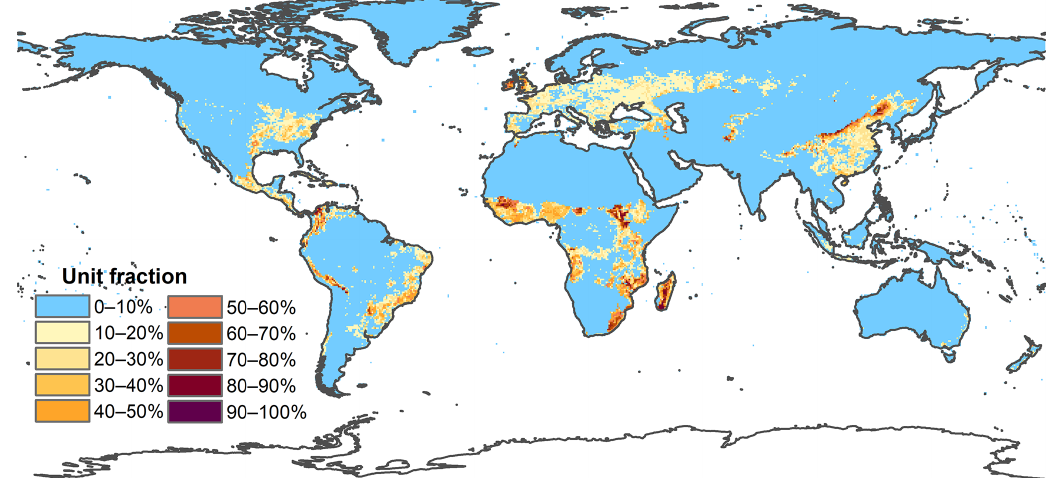
Figure A5. Spatial distribution of multiyear average fraction of managed pasture from 2001–2015 at 0.5 × 0.5arcdeg resolution.